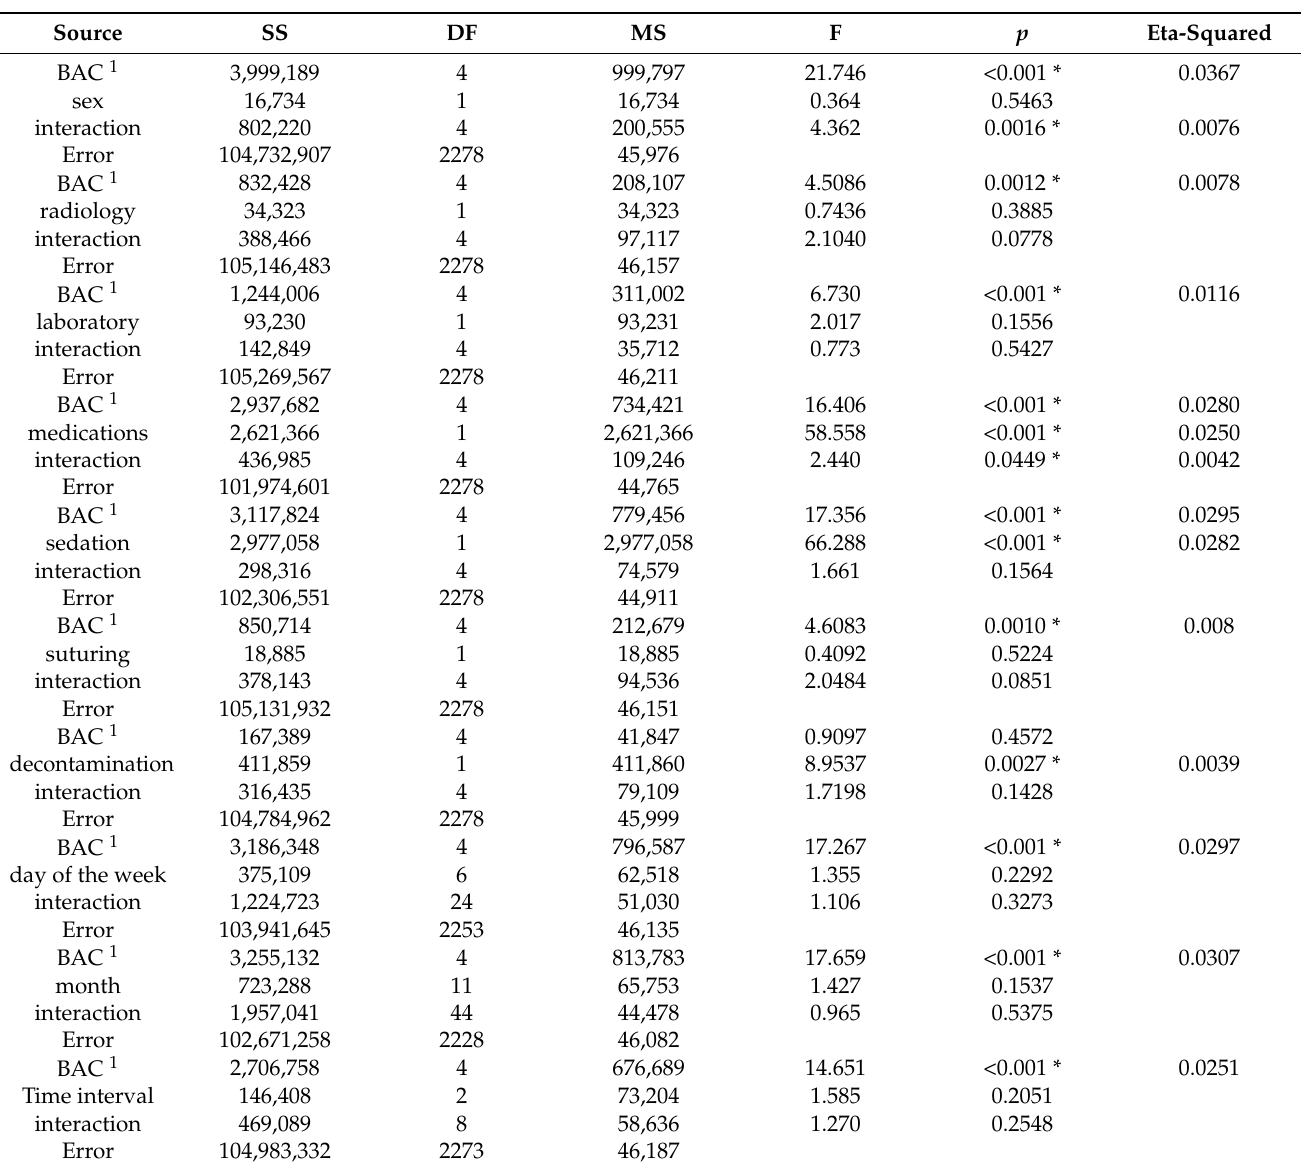
Table 2. The results of multivariate analysis concerning BAC and other covariates and its impact on the length of stay